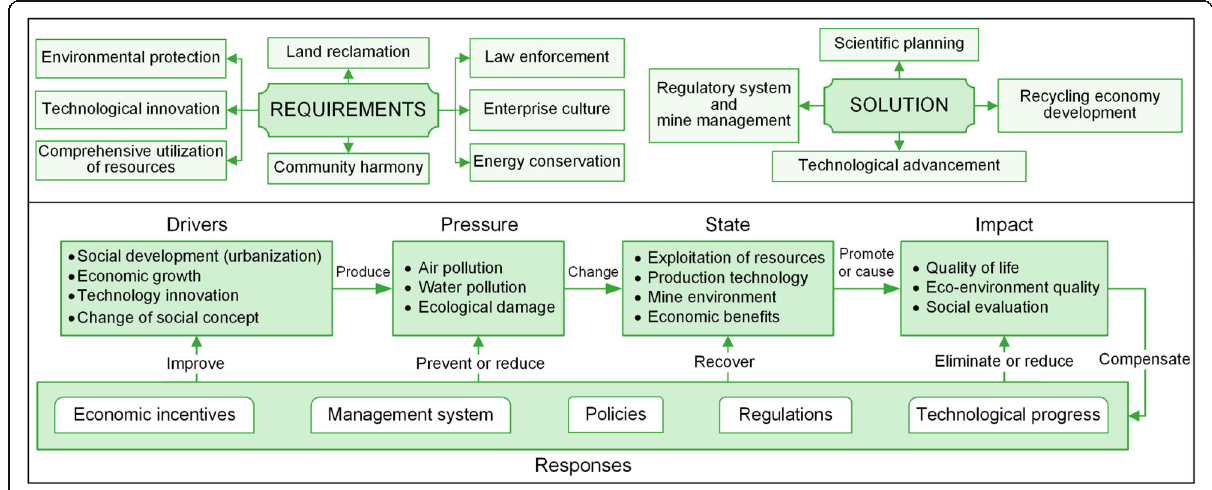
Fig. 4 A comprehensive future framework for the construction of green